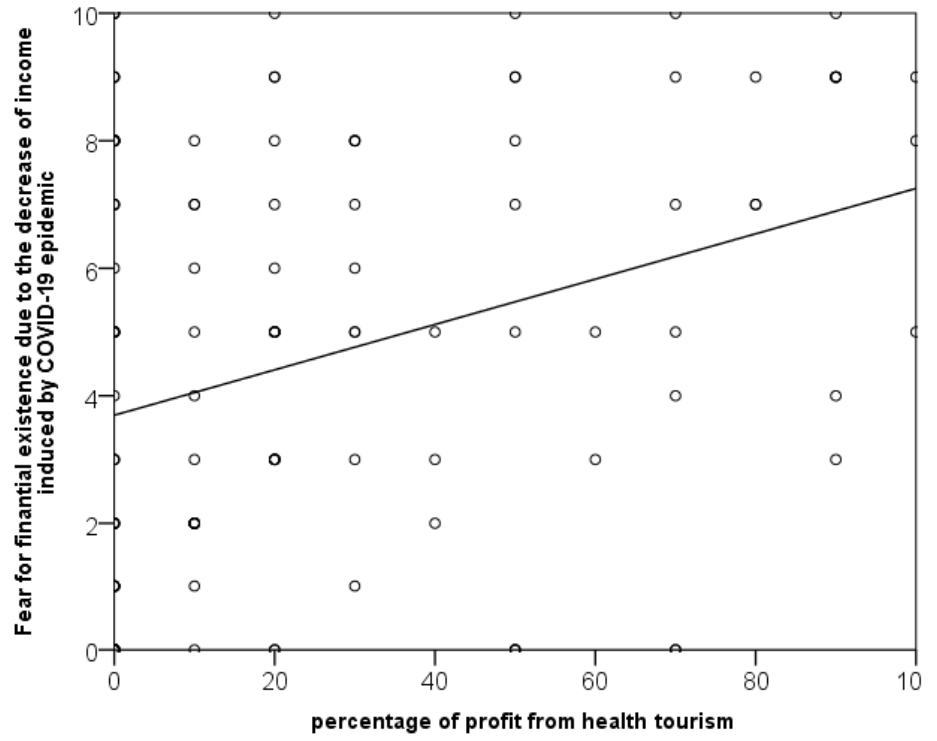
Figure 1. Scatter plot presenting the association of profit from health tourism with fear of financial existence due to the COVID-19 pandemic, with the line demonstrating a linear trend. Those who had a greater fear that they or their loved ones would get sick due to the nature of their work planned to get vaccinated ( p ≤ 0.007; Figure 2). The decrease in office visits was not significantly related to the decision to vaccinate.